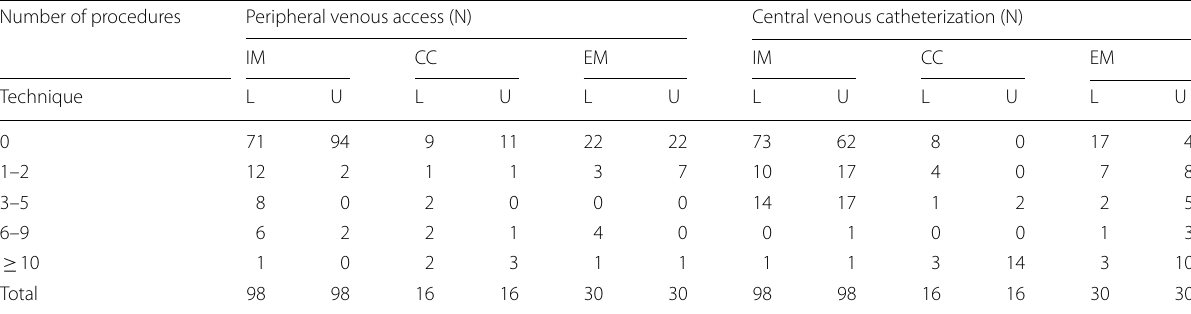
Data stratified by procedure, specialty and technique (i.e. L landmark, U ultrasound-guided) are presented as frequency. CC critical care, EM emergency medicine, IM internal medicine, L landmark, U ultrasound-guided